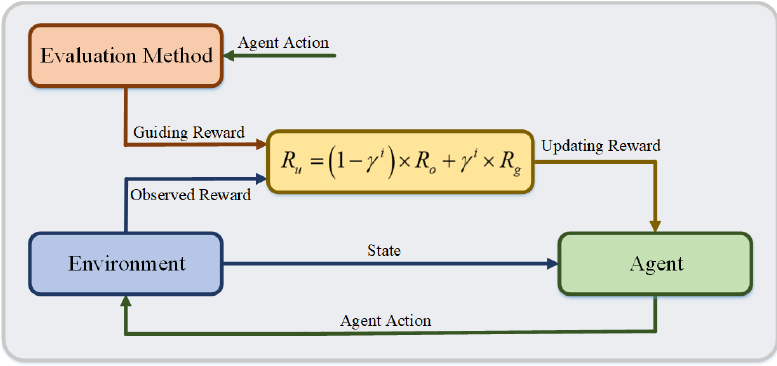
Figure 6. Knowledge-assisted learning method—guiding reward